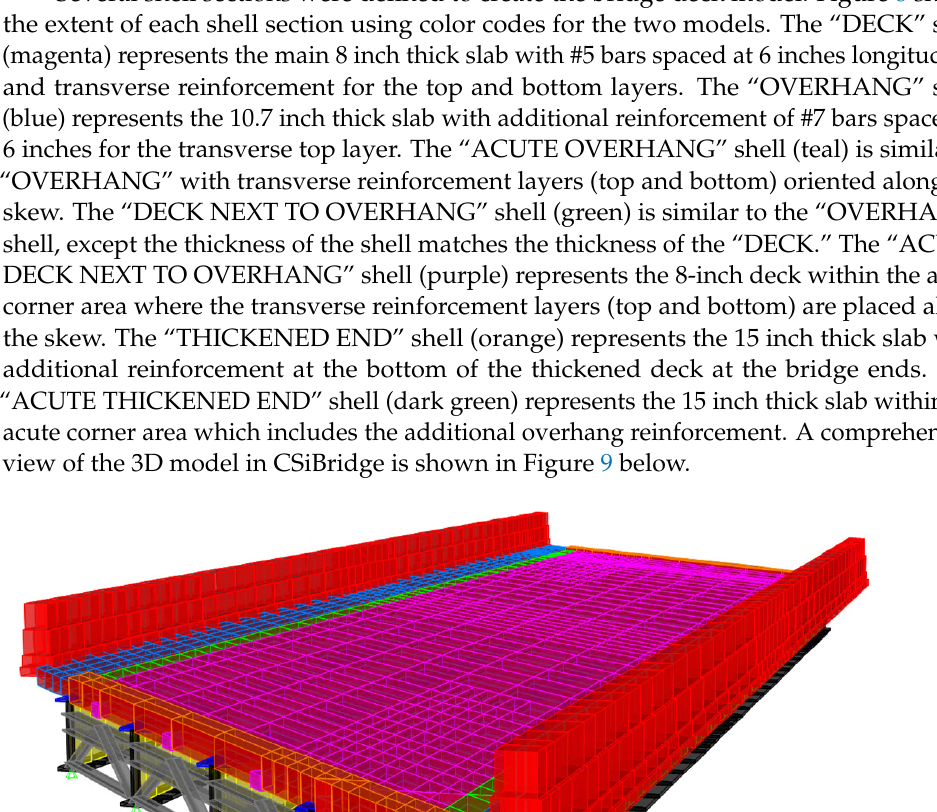
evaluate whether the overhang designed per AASHTO requirements would remain